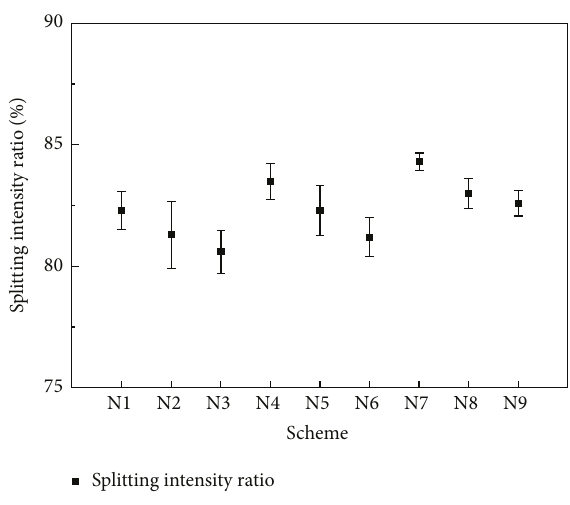
Figure 12: Test results of freeze-thaw splitting.